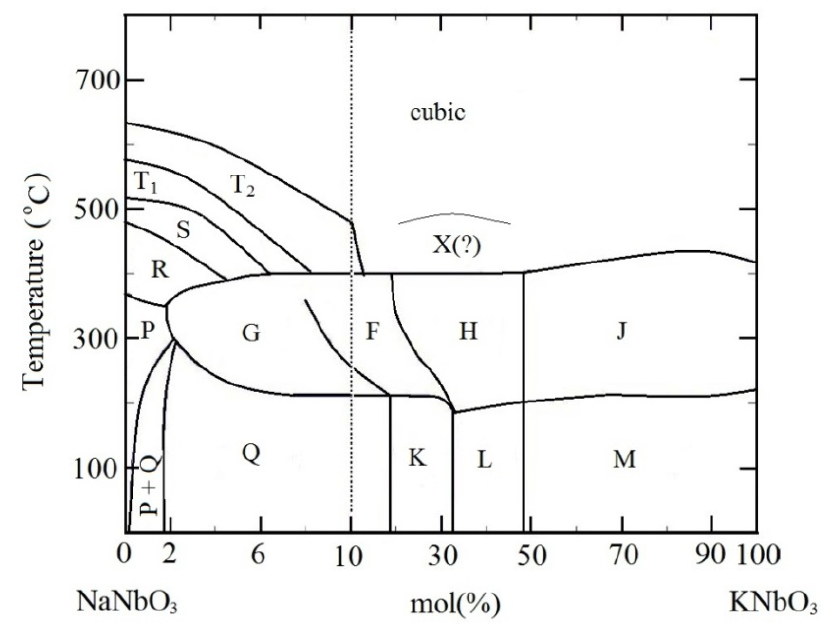
Figure 1. Phase diagram of NaNbO from [22], Copyright 1976 ICUr.